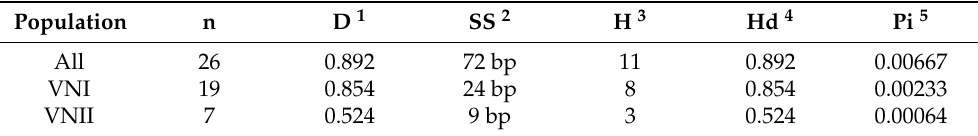
Table 2. Genotypic diversity of clinical Cryptococcus neoformans isolates from Peru, showing the values for the whole population and per molecular type.